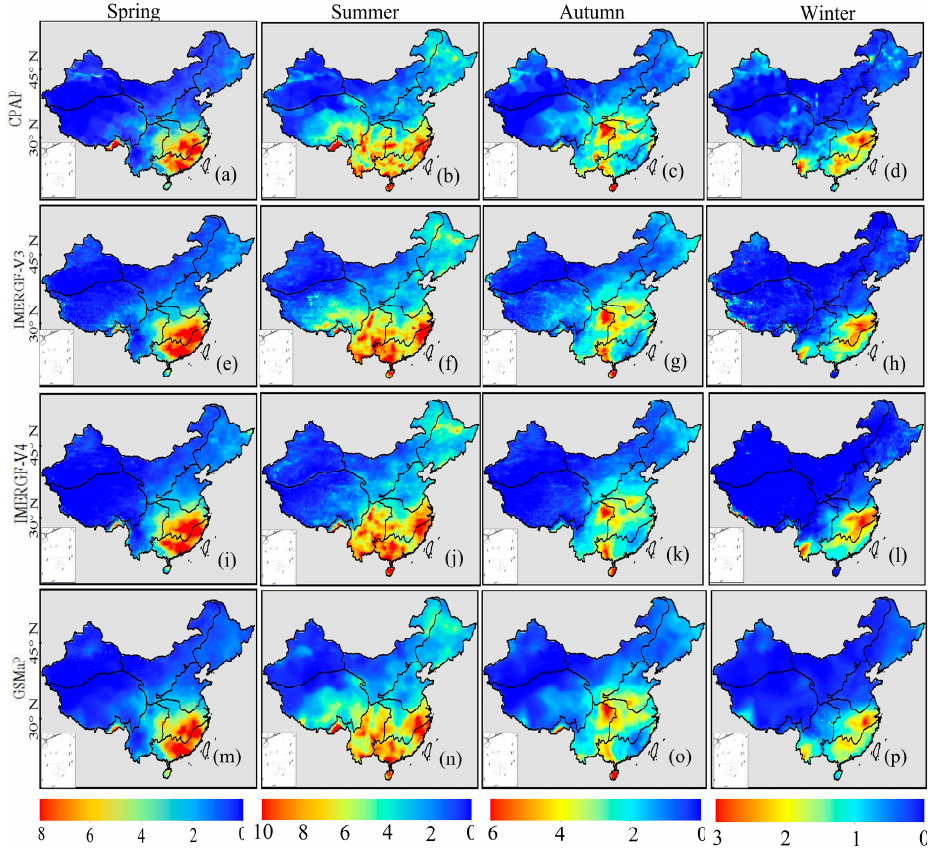
Figure 4. Seasonal daily average precipitation distributions over mainland China for the IMERGF-V3, IMERGF-V4, GSMaP, and CPAP products from March 2014 to February 2015 ( a – p ).